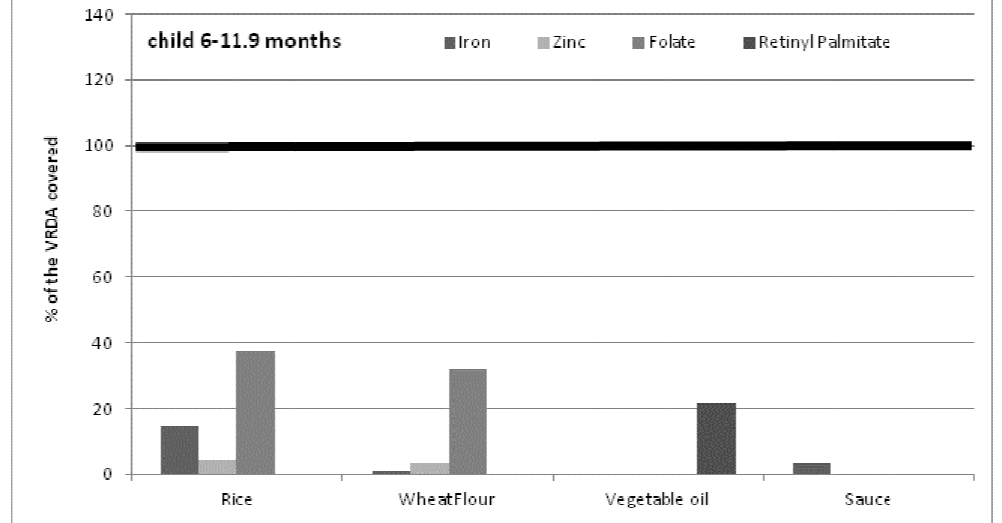
Figure 2. Percentage of VRDA consumed fortified food